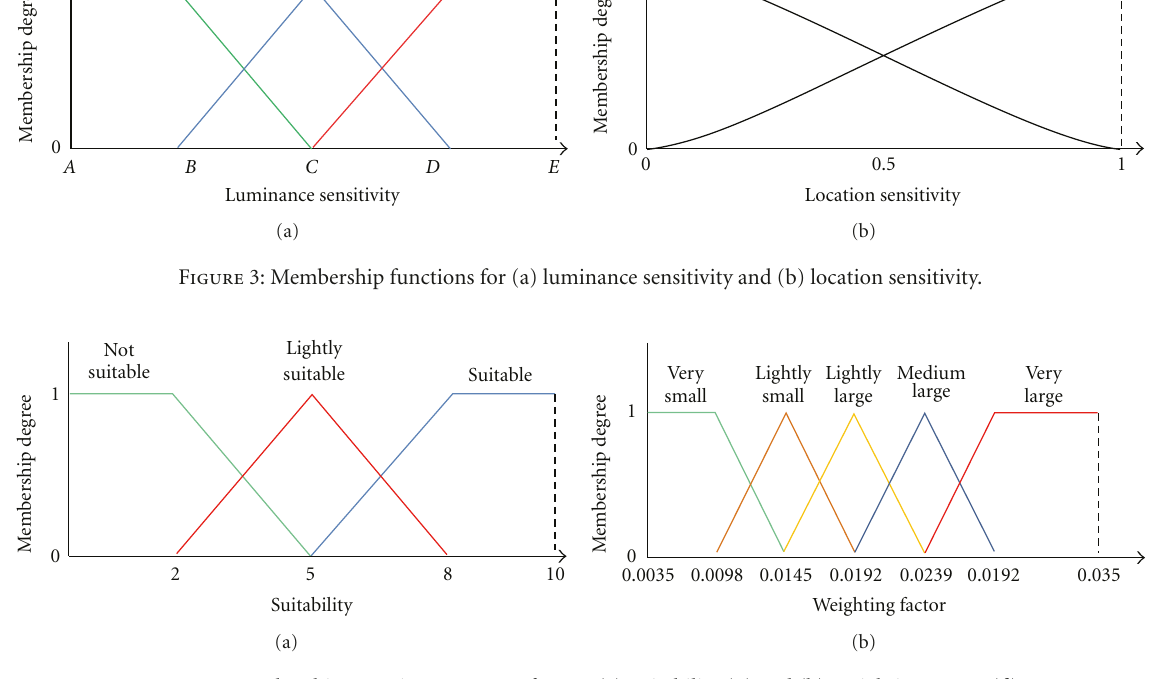
Figure 4: Membership Functions outputs of DFIS, (a) Suitability ( α ) and (b) Weighting Factor ( β